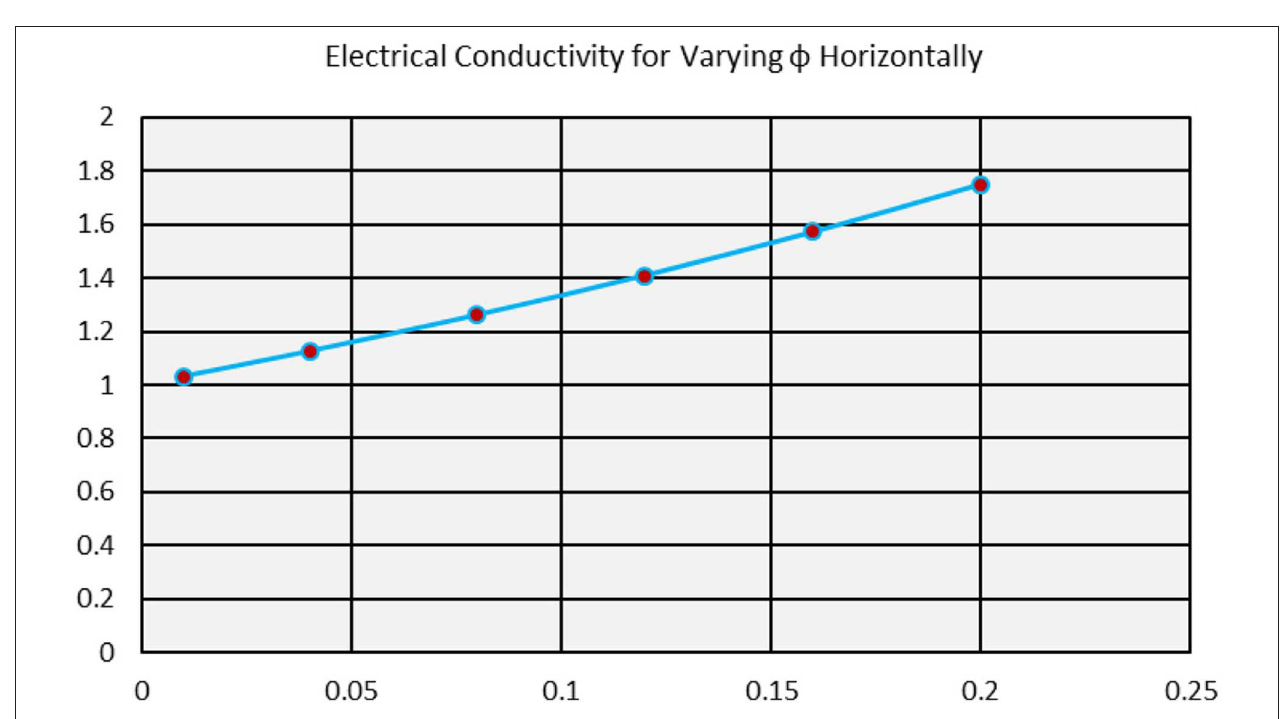
FIGURE 18 | The effects of φ on Electrical